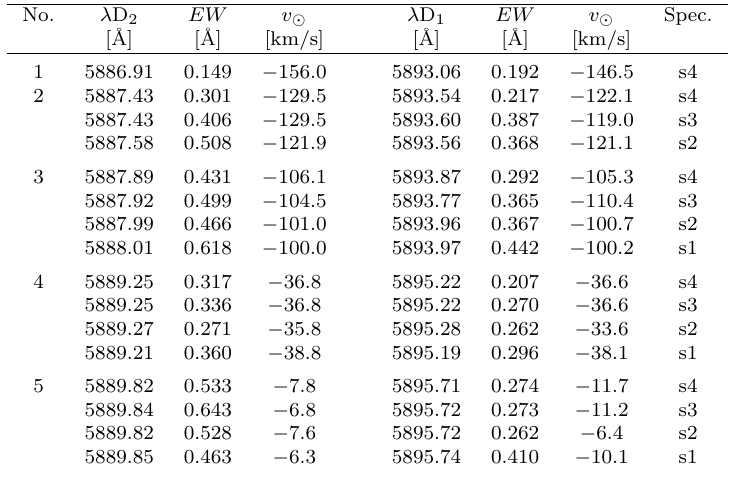
Table 4. Results of the Gaussian decomposition of the Na ID lines in the spectrum of 89 Her. The radial velocity is heliocentric.